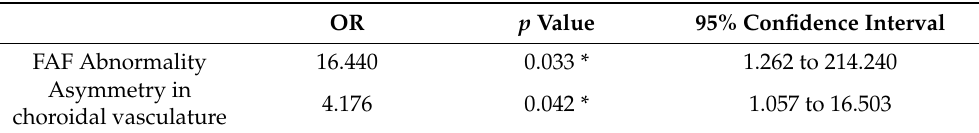
Table 2. Risk factors for eyes with heterogenous deficits and an imbalance of choriocapillaris flow were defined in accordance with the choriocapillaris flow area (CCFA) ratio <58.5% and the coefficient of variation (CV) of the CCFA ratio ≥ 0.165. OR p Value 95% Confidence Interval FAF Abnormality 16.440 0.033 * 1.262 to